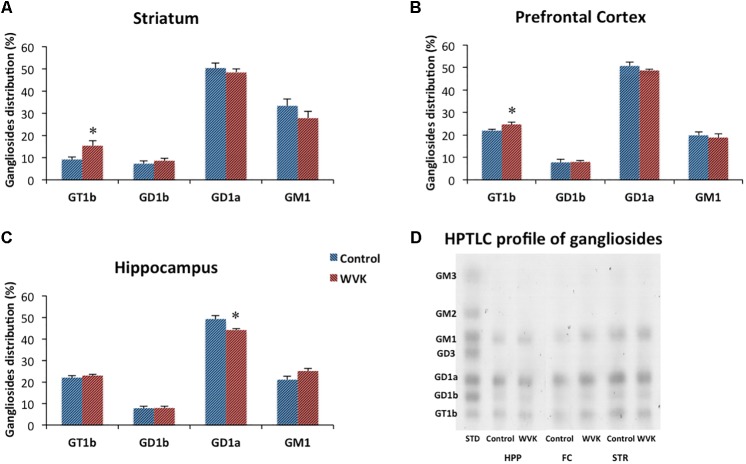
Effect of WVK treatment on ganglioside subtypes in specific brain regions. Figures show gangliosides in (A) striatum; (B) prefrontal cortex; (C) hippocampus; (D) ganglioside HPTLC gel. Values are mean ± SEM, n = 6–7 rats per group. Group differences within a given brain region were analyzed by Student’s unpaired t-test. Statistically different from control group, ∗p < 0.05.